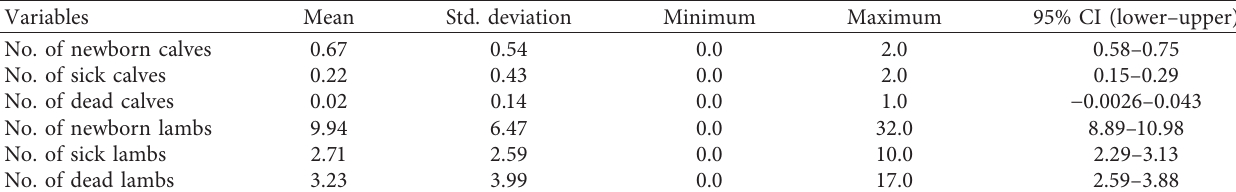
Table 1: Mean annual calf and lamb delivery, morbidity, and mortality distribution in the study area ( N � 150). Variables